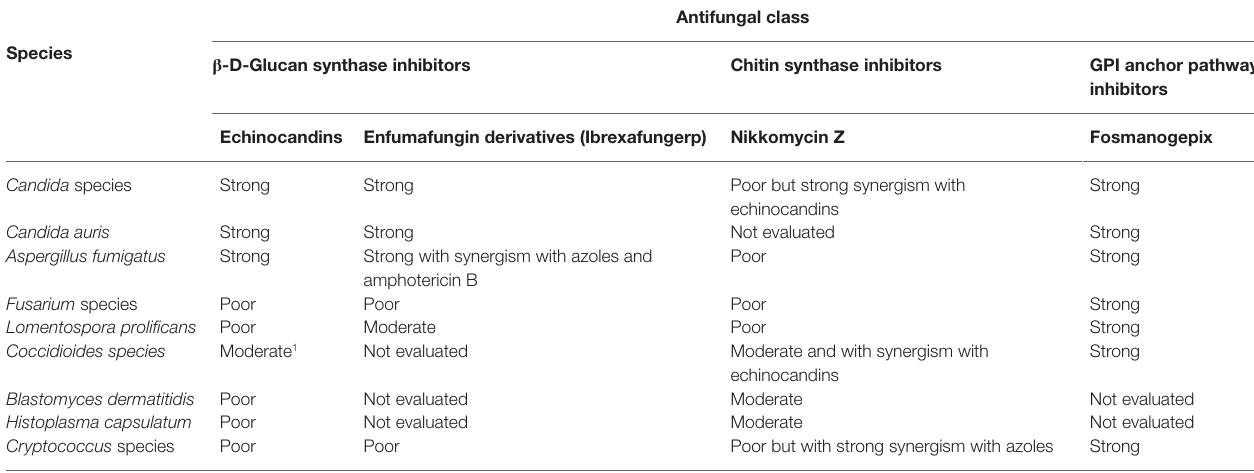
TABLE 1 | In vitro activity of the main cell wall antagonists.